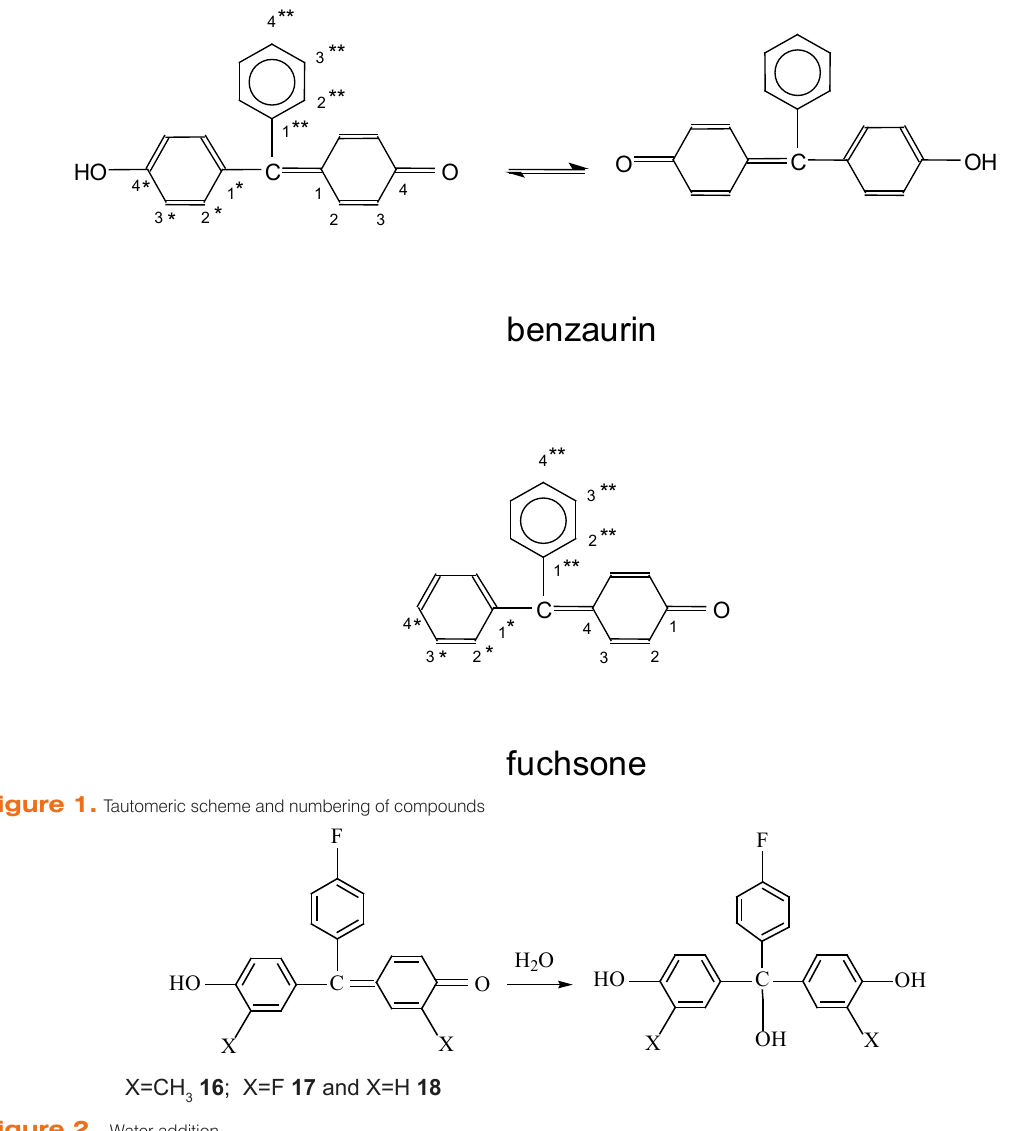
phenylcarbinol (5) was obtained from PhMgBr and 4*- fluoro-4-hydroxybenzophenone using a similar method with a 72% yield as an orange solid. M.p.110 - 112 0 C.